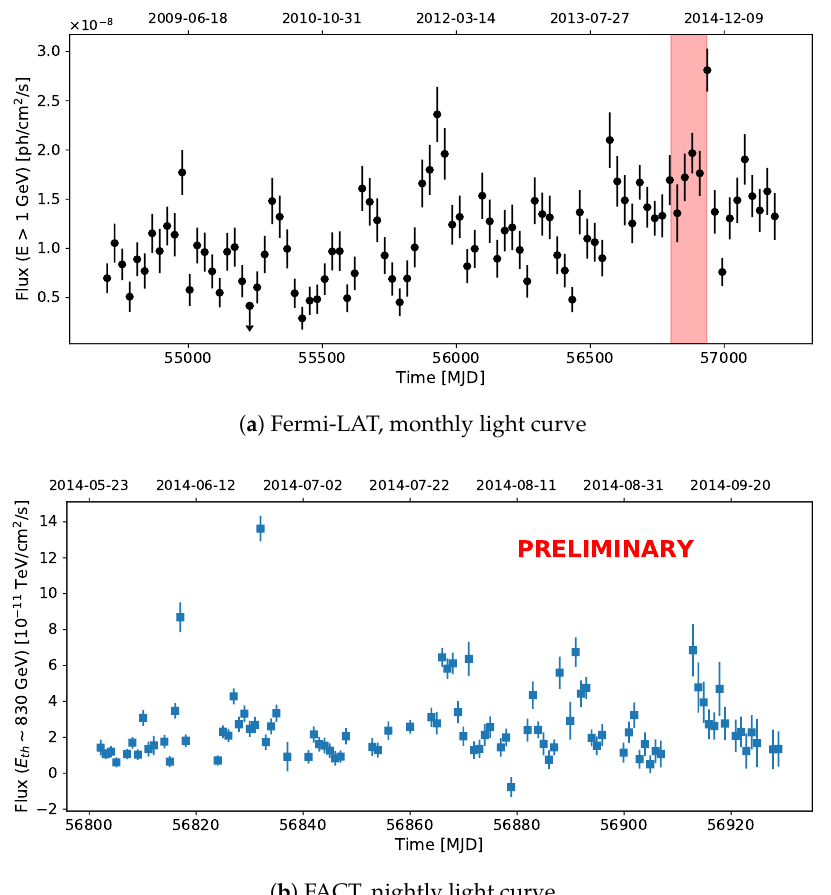
Figure 1. ( a ) Fermi-LAT photon flux light curve (in units of photons/cm 2 /s) for photon energies E > 1 GeV spanning over a period of seven years, using a bin size is 28 days. The red band indicates the time range of the FACT data. ( b ) FACT energy flux light curve (in units of TeV/cm 2 /s) with nightly binning with an energy threshold E th ∼ 830 GeV. The light curve spans a time interval of almost five